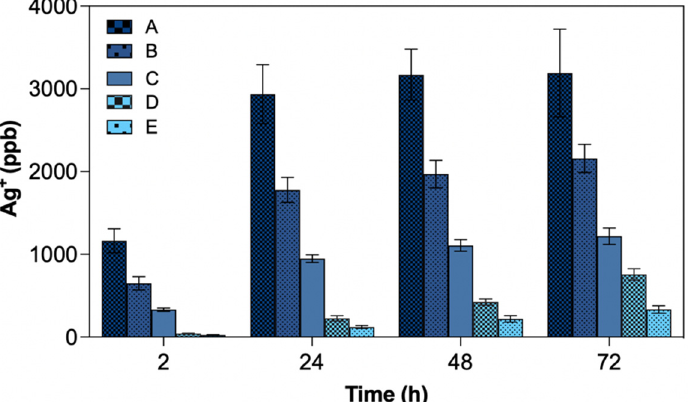
Figure 6. Release of Ag + from the AgNP-embedded hydrogels measured by ICP.